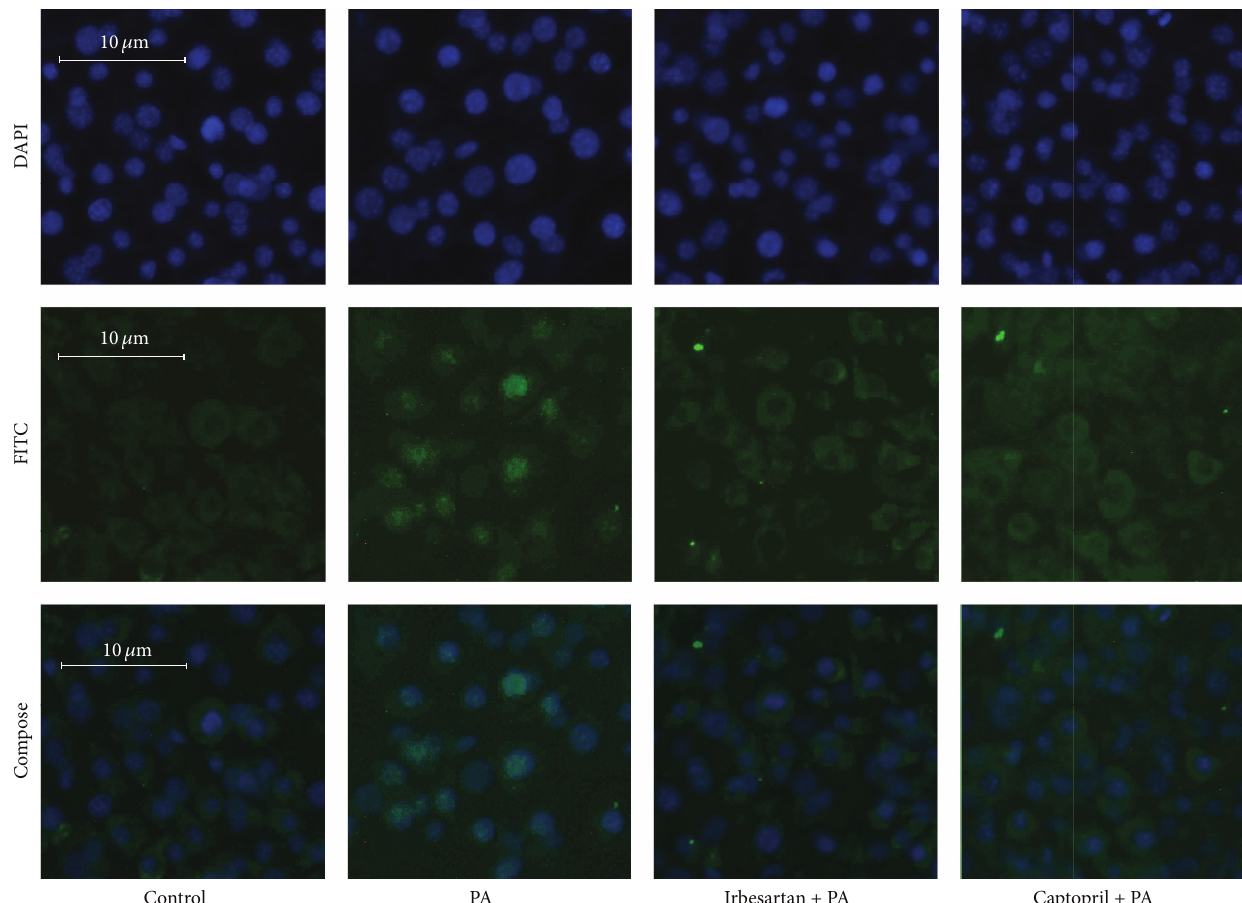
Figure 7: Effect of PA with or without Irbesartan or Captopril pretreatment on NF- 𝜅 B p65 subunit translocation in 3T3-L1 adipocytes. DAPI: DAPI staining of nucleus; FITC: FITC staining of NF- 𝜅 B p65 subunit; Compose: composite images of DAPI and FITC.